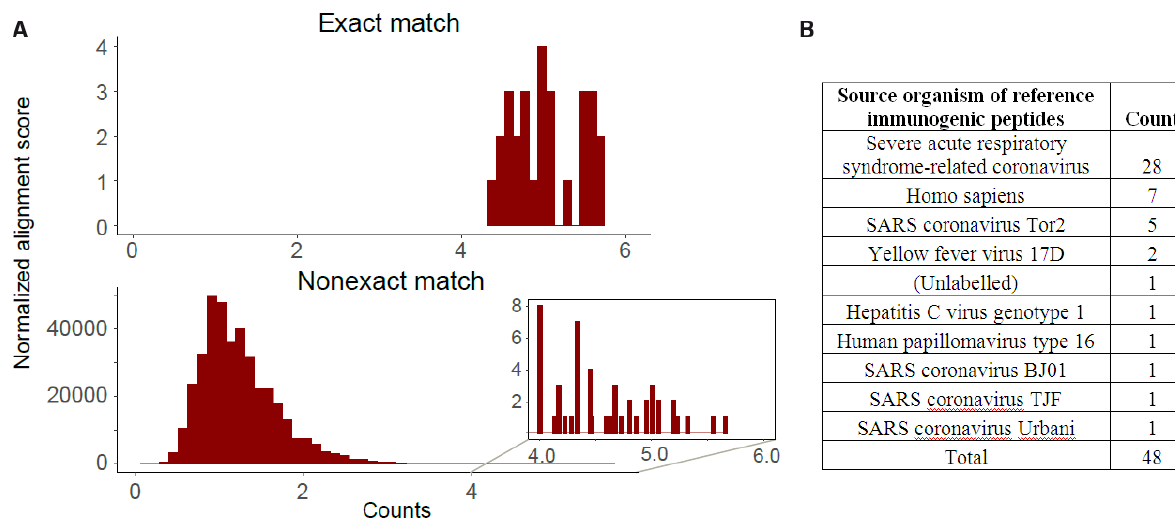
Figure 1. 2019-nCoV peptides with high sequence similarity to immunogenic peptides in IEDB. A. Comparison of normalized sequence alignment score for peptides with exact and non-exact matches. B. Number of target peptides grouped by their source organism.